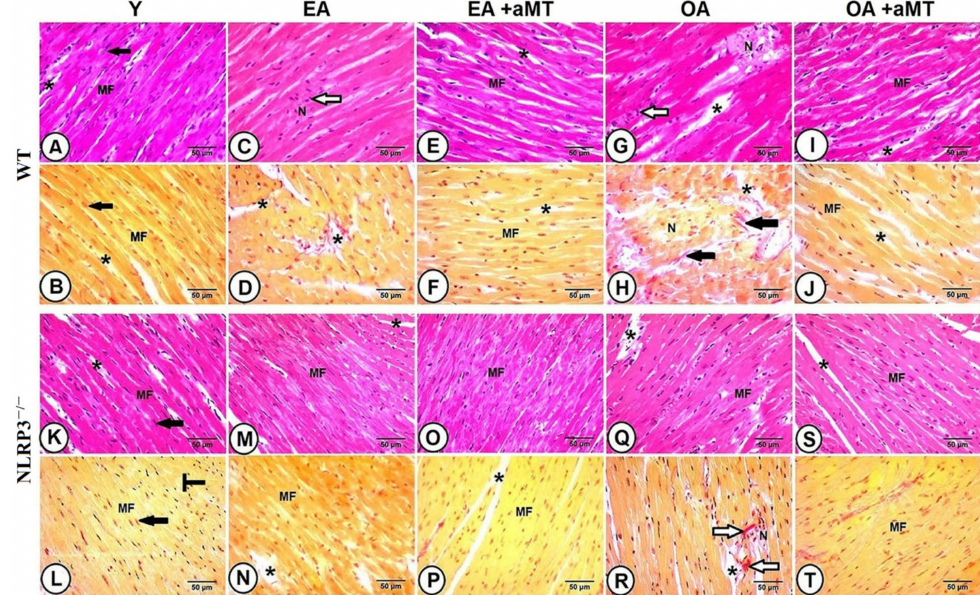
Figure 2. Effect of NLRP3 deletion and melatonin supplementation on age-associated histological changes of cardiac muscle fibers. ( A , B ) Left ventricle (LV) of the Y WT mice showing the normal cardiac muscle fibers (MF) architecture, with central nucleus (black arrows), and narrow interstitial spaces (black asterisks). ( C , D ) LV of the EA WT mice revealing an initial necrotic degree (N), with lym- phocytic infilterates (white arrow) and wide interstitial spaces (black asterisks). ( E , F ) The conservative effect of melatonin on maintaining normal muscle fibers (MF) of EA mice, with narrow interstitial spaces (black asterisks). ( G , H ) LV of the OA WT mice demonstrating severe necrotic changes (N), with lymphocytic infiltrations (white arrow), excessive collagen deposition (black arrows), and wide interstitial spaces (black asterisks). ( I , J ) The protective effect of melatonin on improving cardiac muscle fibers (MF) and minimizing interstitial tissues (black asterisks) in OA animals. ( K , L ) LV of the Y NLRP3 − / − mice showing the normal cardiac muscle fibers organization (MF), with centrally located nuscle (black arrows) and interstitial spaces (black asterisks). ( M , N ) LV of the EA NLRP3 − / − mice revealing wide interstitial spaces (black asterisks) without necrosis. ( O , P ) The preservative effect of melatonin on keeping normal structure of cardiac myocytes (MF) in EA mice. ( Q , R ) LV of the OA NLRP3 − / − mice demonstrating less necrotic changes (N), interstitail spaces (black asterisks), and collagen deposition (white arrows). ( S , T ) The beneficial effect of melatonin on improving cardiac architecture, with narrow interstitial spaces (black asterisk). Bar = 50 µ m. ( A , C , E , G , I , K , M , O , Q , S ) stained with H&E stain, while ( B , D , F , H , J , L , N , P , R , T ) stained with Van Gieson